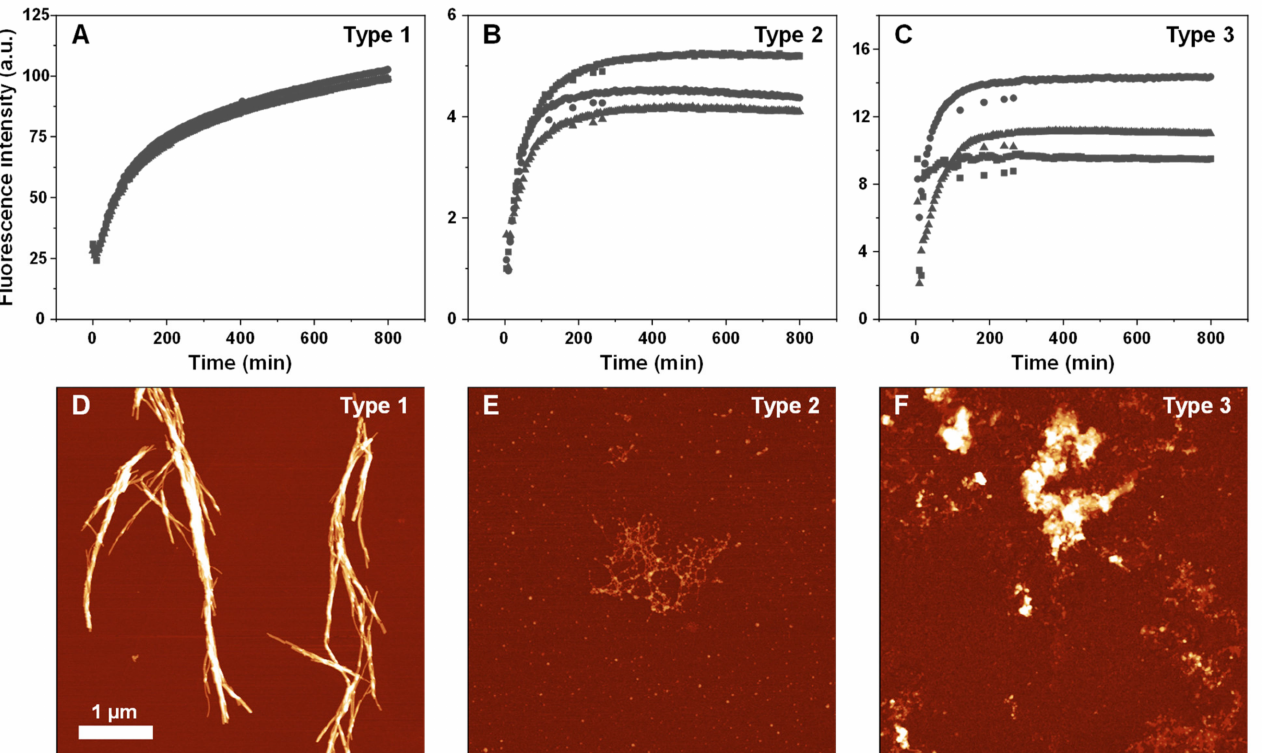
Figure 4. Self-replication kinetics ( A – C ) and atomic force microscopy images ( D – F ) of three types of lysozyme aggregates. Kinetic curves are from three repeats (different symbols represent separate samples). Self-replication and AFM imaging procedures are described in the Materials and Methods section. Raw data are available in the Supplementary